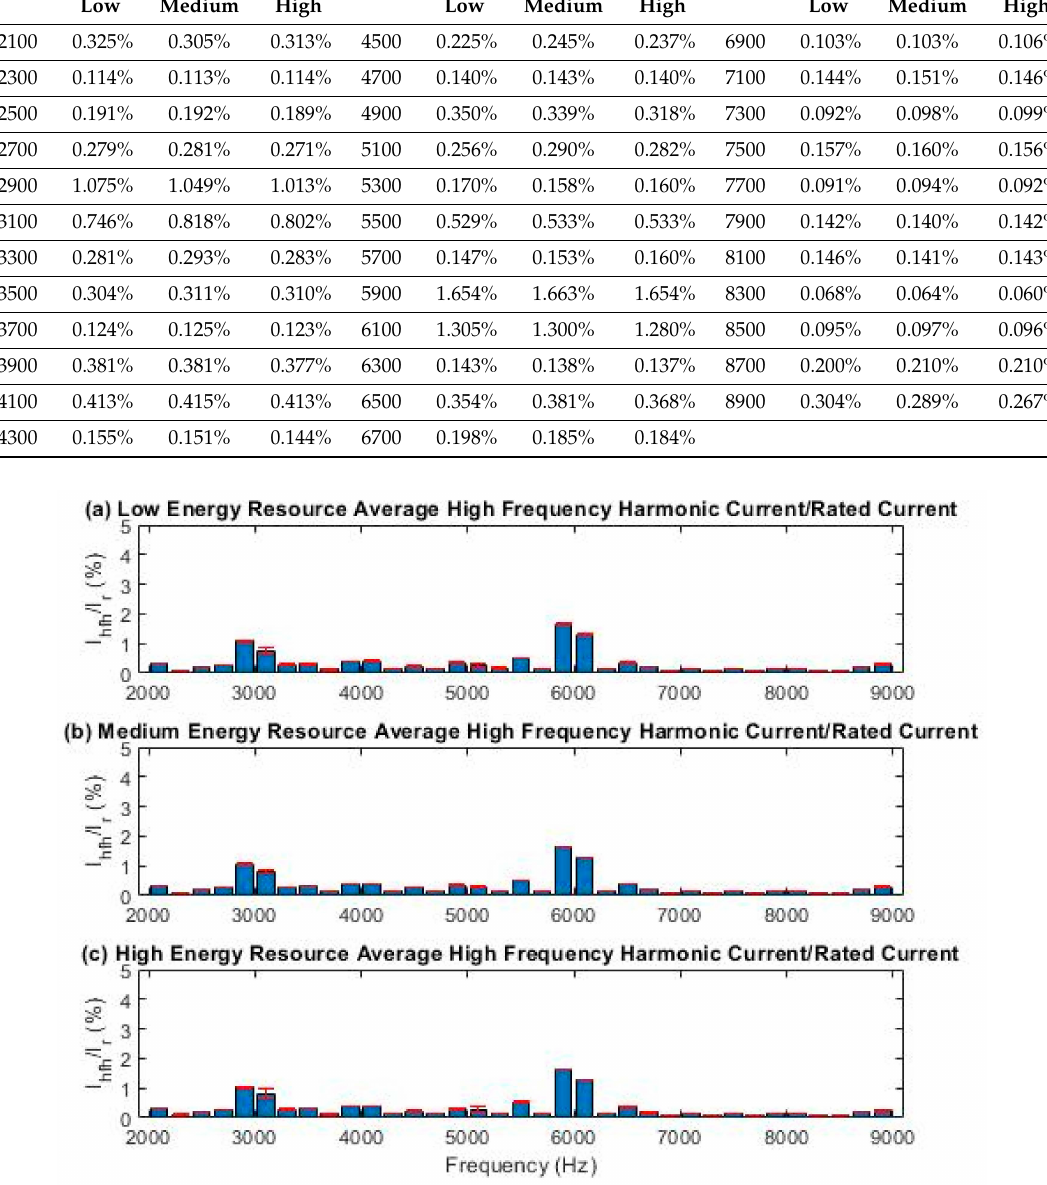
Figure 11. Laboratory trial average ratios of high-frequency harmonic current amplitude to rated current for ( a ) low energy, ( b ) medium energy, and ( c ) high energy resource classifications, including error bars, which represent the standard deviation of the data